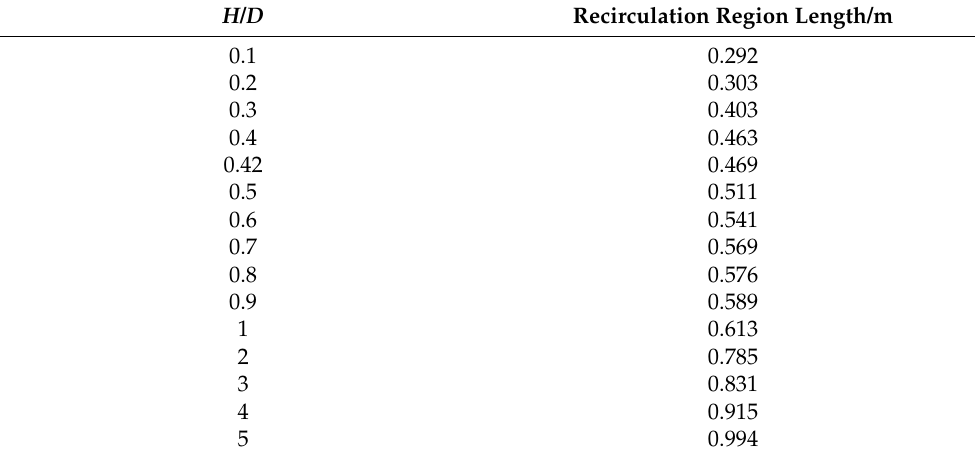
Table 3. Recirculation region length with different aspect ratios. H /